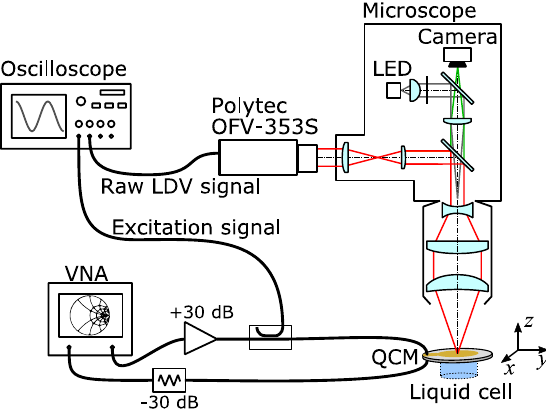
Figure 2. Sketch of the LDV microscope used to study the normal motion of the QCM surface. The unit OFV-353S is a laser-Doppler vibrometer supplied by Polytec (Waldbronn, Germany).